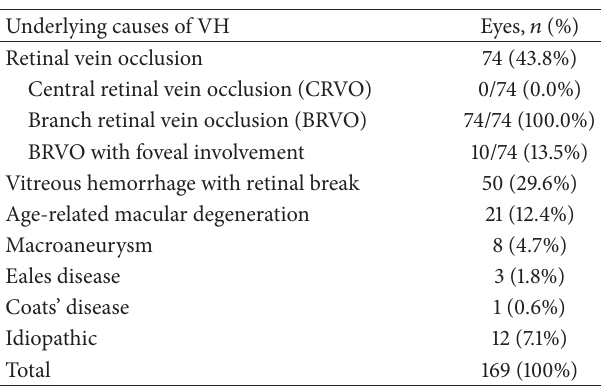
Table 1: Causes of acute-onset vitreous hemorrhage (VH) of preop- eratively unknown origin.